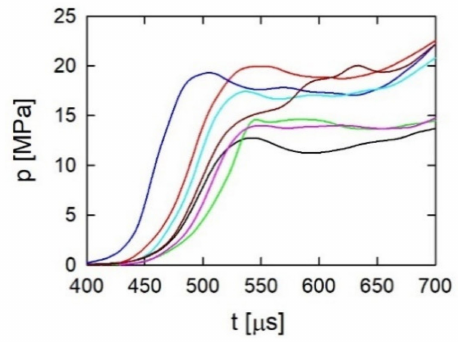
Figure 11. Initial parts of pressure courses were measured in the live firing